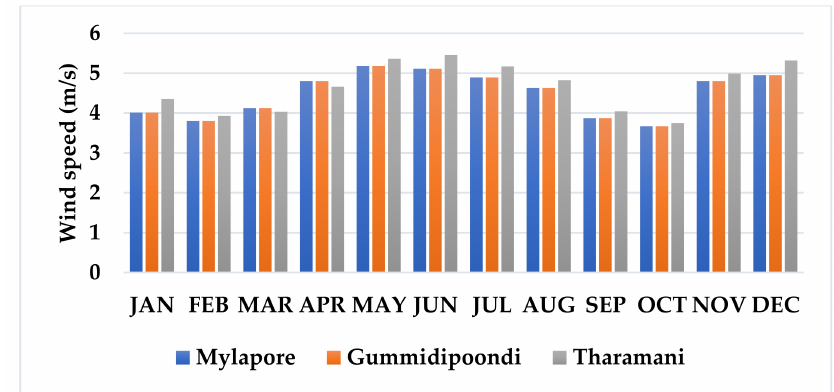
Figure 13. Annual wind speed of selected locations (m/s).